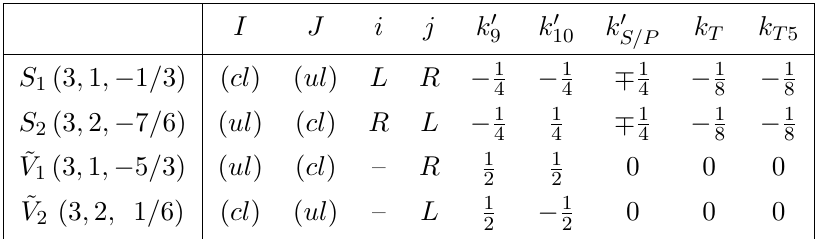
Table 8 . Coefficient matrix for the LQ Wilson coefficients defined in eq. (4.29), following ref.